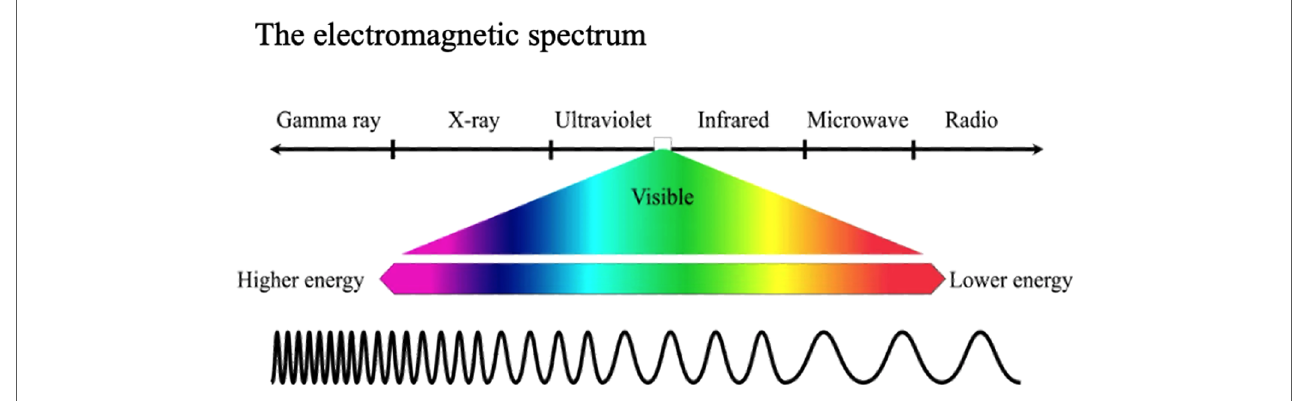
FIGURE 1 The central part of the electromagnetic spectrum consists of light of wavelengths visible to human eyes, ranging from violet to red. When seen together they are apparent as “ white ” light.